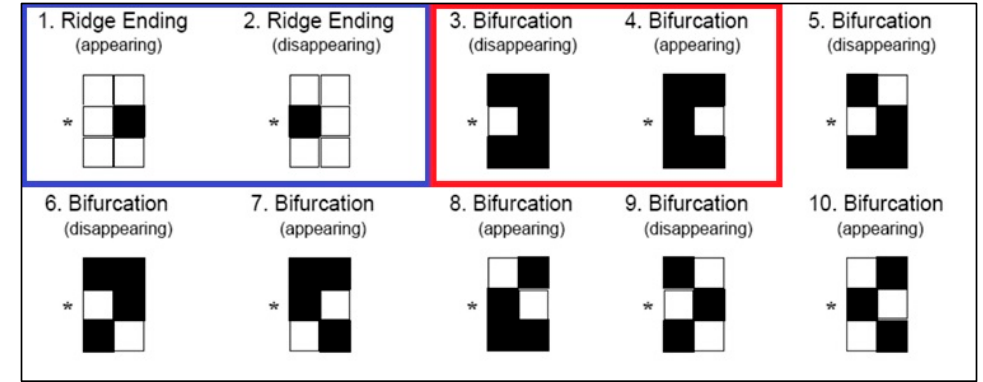
Figure 9. Feature extraction template s . Horizontal image sweeps [31,32]. The templates are rotated